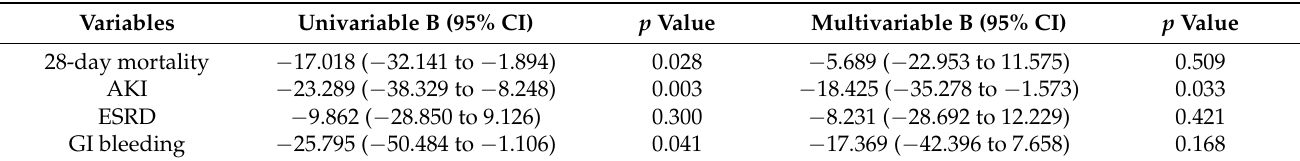
Table 2. General linear model to analyze the independent factors for HLA-DR expression in mono- cytes of septic